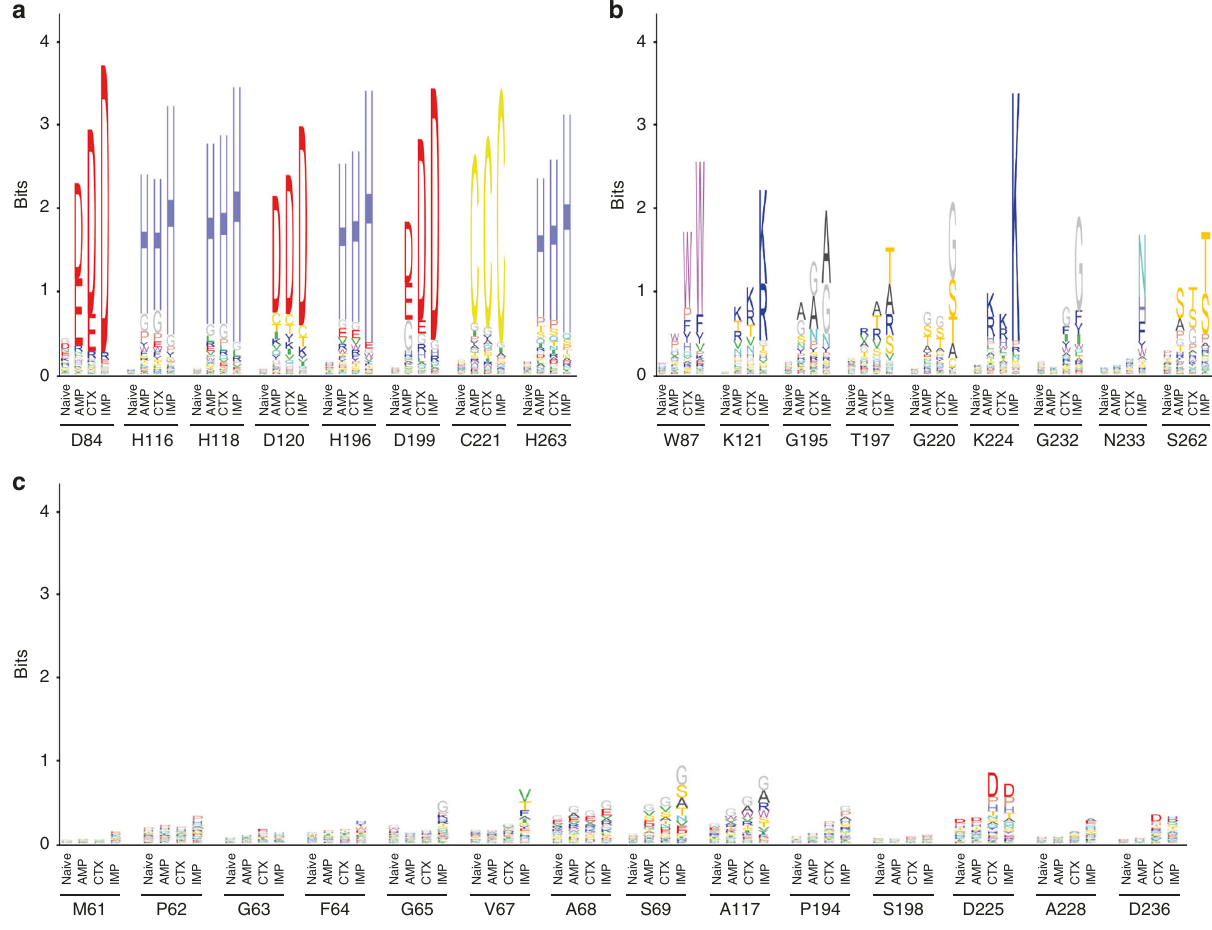
Fig. 3 Sequence logos for essential, substrate-speci fi c, and non-essential residue classes. a Essential residue class. For this class, the sequences obtained from the antibiotic-selected library are dominated by the wild-type residues and sometimes physicochemically similar residues. b Substrate-speci fi c residue class. For this class, the distribution of residue types observed is dependent on the antibiotic used for selection. For example, a broad distribution of amino-acid types is observed among the sequences from ampicillin-selected libraries, whereas a narrower range of amino-acid types is observed among sequences from imipenem-selected libraries. c Non-essential residue class. For this class, a wide distribution of amino-acid types is observed after selection of the libraries with each of the β -lactam antibiotics, suggesting relaxed sequence requirements at these